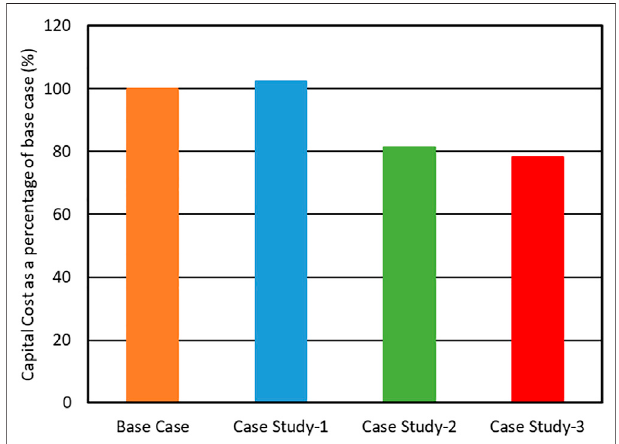
FIGURE 9 | Capital cost comparison of studied cases with the base case for LPG recovery.